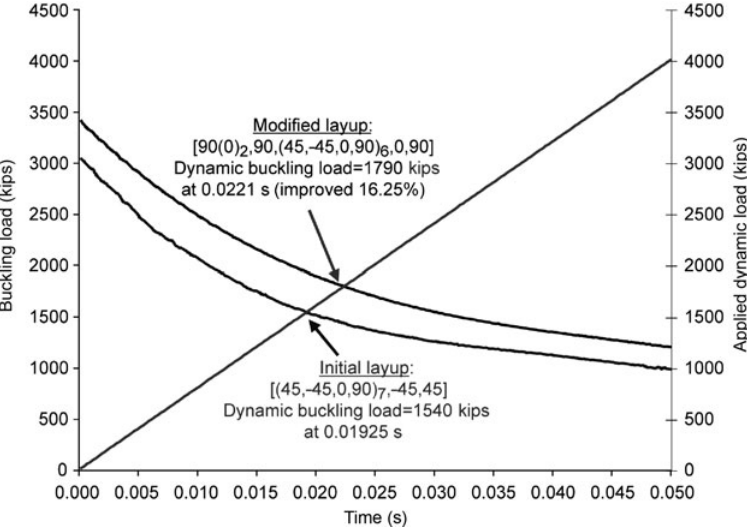
Figure 12 Benefi t of using 90 ° graphite fi bers in plies 1 and 30 on the dynamic buckling load of a graphite epoxy composite shell. (1 kip = 4.45 KN.)